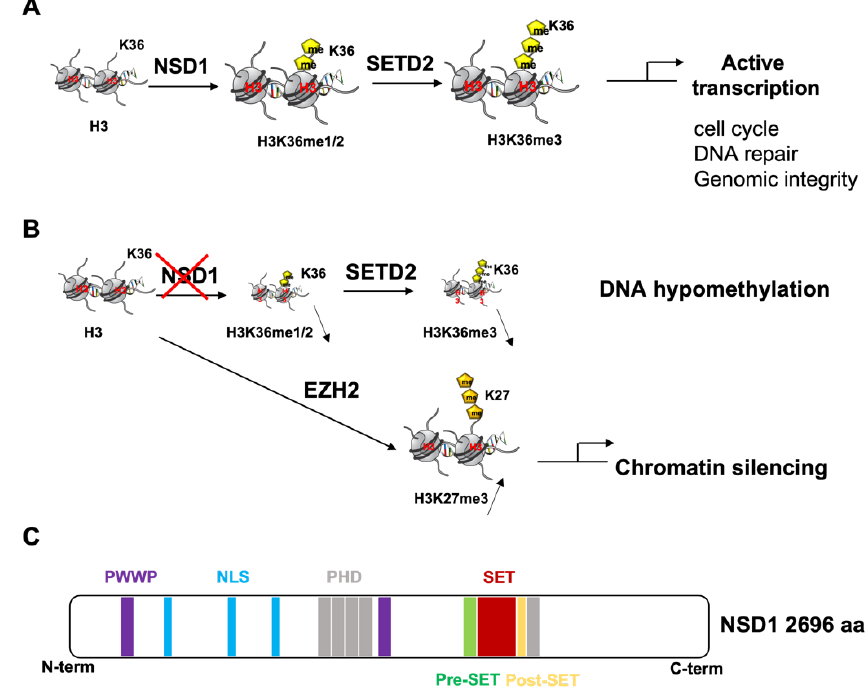
Figure 1. Epigenetic mechanisms driven by the histone lysine methyltransferases NSD1 and SETD2. ( A ) NSD1 and SETD2 regulate cell cycle, DNA repair and genomic integrity. ( B ) NSD1 loss reduces H3K36me2 active transcriptional methylation marks, leading on one hand to H3K36me3 decrease known to be involved in DNA hypomethylation, and on the other hand causing a genome wide accumulation of H3K27me3, a repressive histone modification associated with chromatin silencing, mediated by PRC2-catalytic subunit Enhancer of zeste homolog 2 (EZH2). ( C ) Schematic represen- tation of NSD1 architecture showing the different protein domains. PWWP: proline–tryptophan– tryptophan–proline). NLS: nuclear translocation signals. PHD plant homeodomain zinc fingers.